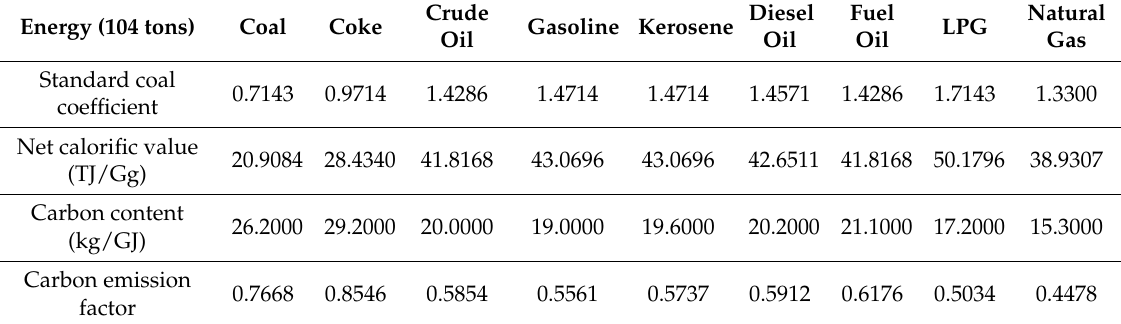
Table 2. Carbon emission factors of different energy